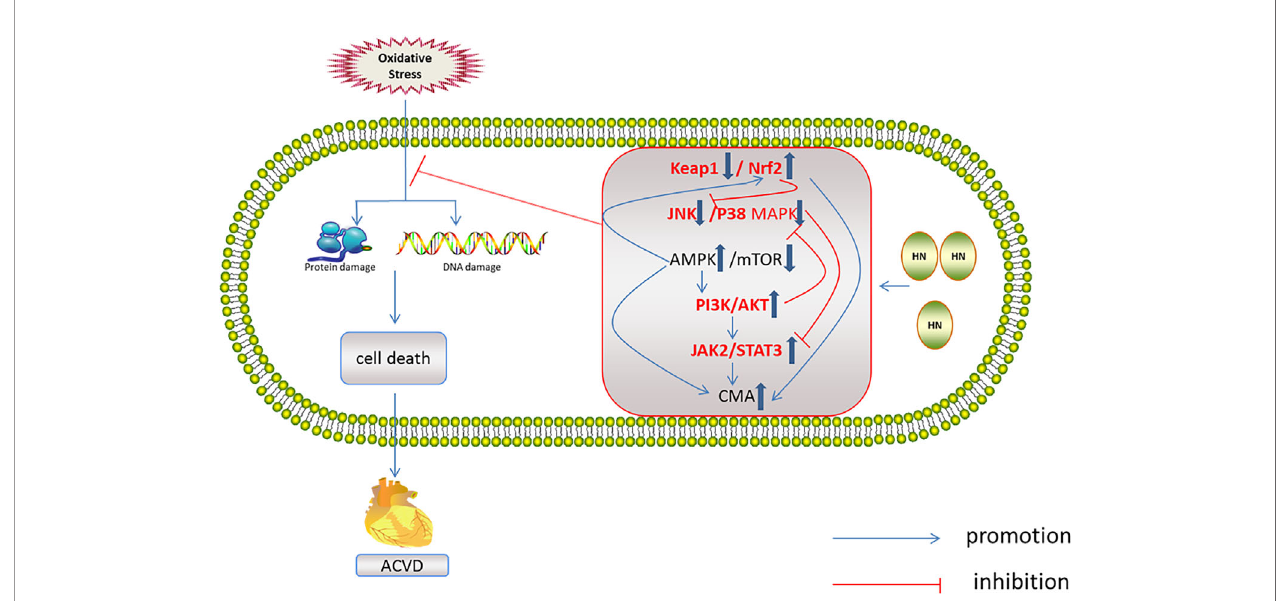
FIGURE 6 | Regulation of HN on redox system in ACVD. HN activates AMPK and PI3K/AKT, JAK2/STAT3 signaling pathways, induces CMA, promotes Nrf2 release, and inhibits JNK/p38MAPK pathway, inhibits oxidative stress damage and ACVD (inside the box: the red font represents the future research direction, the blue thick arrow represents the in fl uence of HN on the fi ve signal pathways, and other signs form a signal